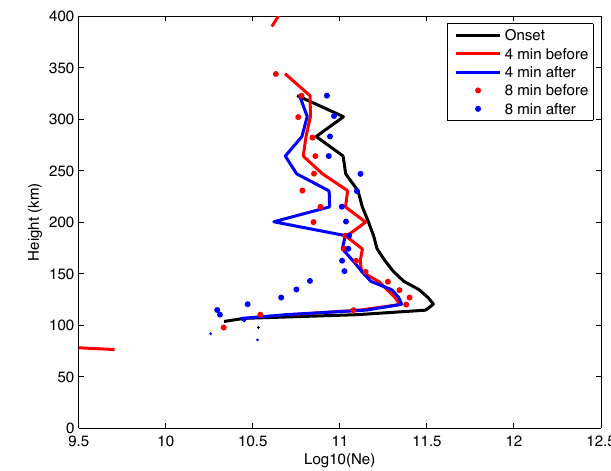
Fig. 13. Ionospheric electron density profiles as recorded by the EISCAT Tromsø radar at the onset of substorm 3. The solid black line is the electron density at the time when the radar beam encoun- tered the precipitation at 22:11UT. The red curve shows the electron density 4min earlier, and red dots 8min earlier. The blue curve in- dicates the electron density profile 4min after and blue dots 8min after,